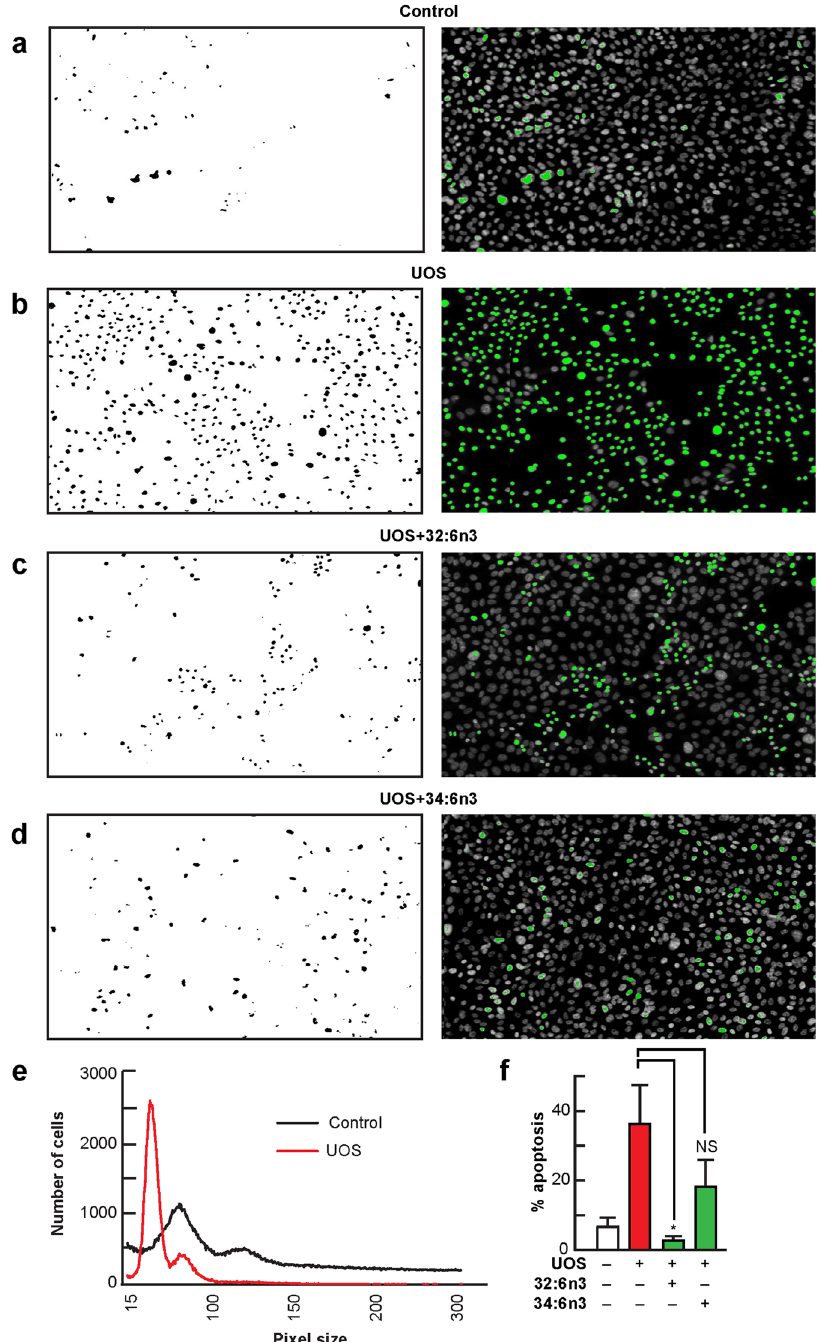
Figure 4. 32:6n3 and 34:6n3 ameliorate UOS-induced primary human RPE cell death. ( a ) Untreated (control) RPE cells. RPE cells underwent UOS for 16 hours ( b-f ). When 32:6n3 or 34:6n3 were added, cell death was prevented ( c , d , f ). Typical fields of cell cultures are represented in the right column. Nuclei are labeled with Hoechst staining, and the dead cells are highlighted in green. These were separated using an intensity threshold algorithm and counted using an Image J macro (left column) 70 . ( e ) Quantification of live (control cells; black curve) and dead (UOS cells, red curve) cells was based on nuclear size 70 . Error bars, SEM; * p < ELVs upregulate pro-homeostatic and anti-apoptotic protein abundance with attenuation of apoptosis in RPE VLC-PUFAs play a vital role in PRC structure and function, which are compromised when DHA levels are reduced due to genetic ablation of AdipoR1 41 . A consequence of this is that retinal degeneration ensues. To counter neurodegeneration, cells activate neuroprotective pathways that sustain a balance between pro- and anti-apoptotic signaling. The genetic and cellular mechanisms that govern the expression of these pro-survival